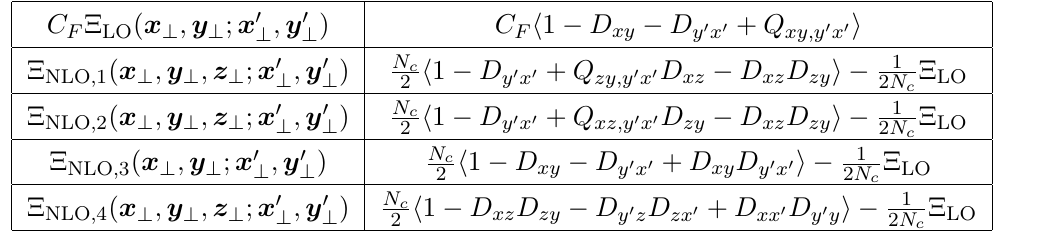
, y ⊥ → y 0 transformations. ⊥ ⊥